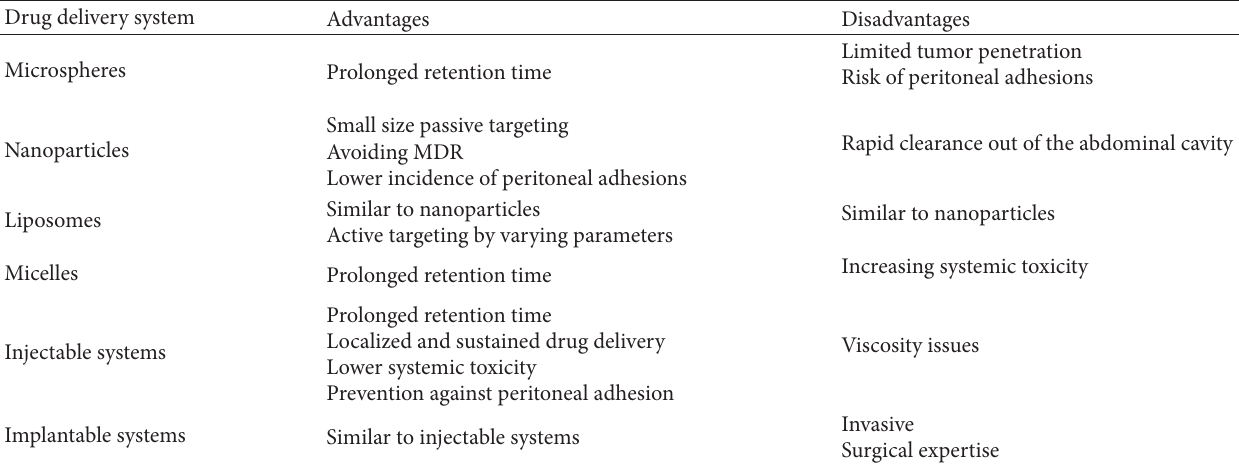
Table 2: Advantages and disadvantages of the drug delivery systems investigated for IP